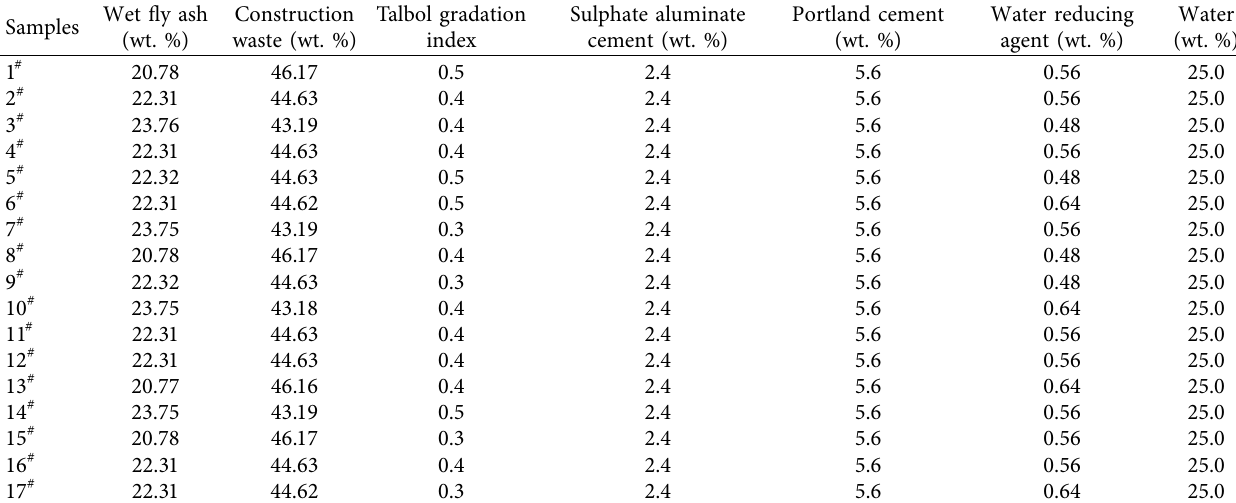
Table 4: Mix ratios of filling material for orthogonal test.